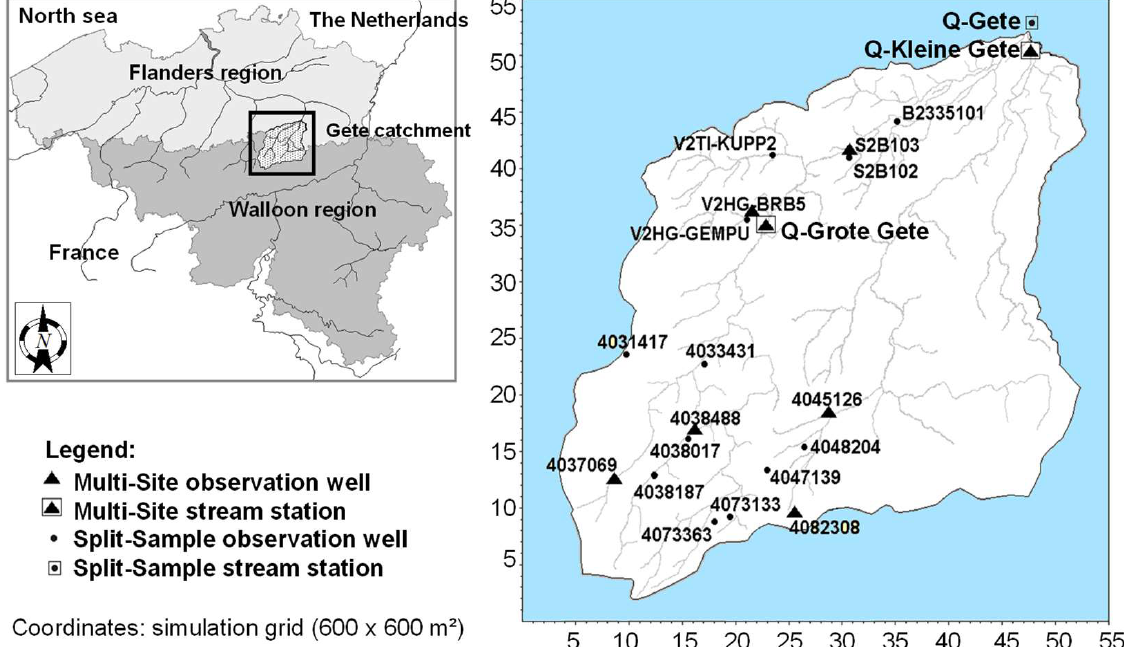
Figure 1. Spatial distribution in the study site of the stream gauging stations and wells used in model calibration and evaluation (after [48] ).